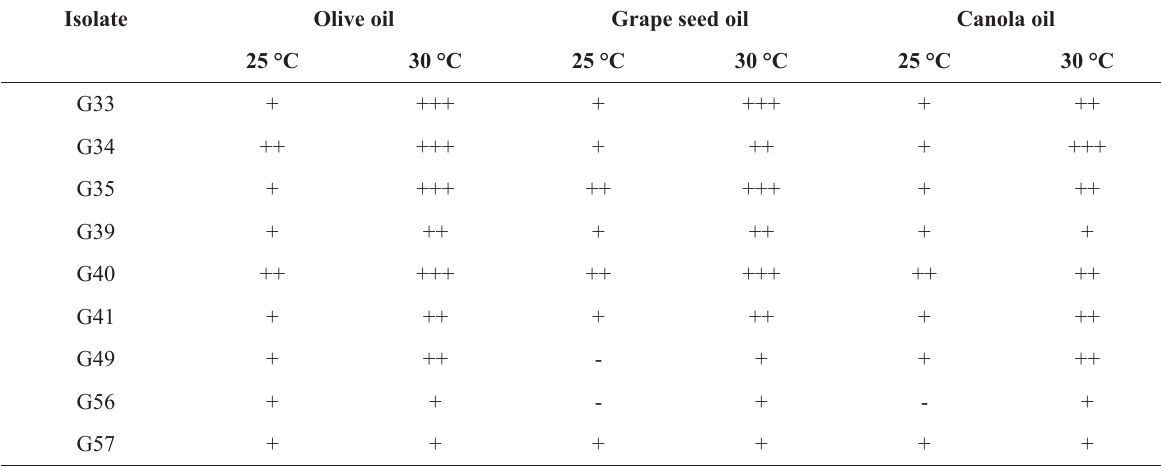
Results of fluorescence intensity obtained by the isolates in solid medium using olive oil, grape seeds oil and canola oil as substrates. Growth at 25 °C and 30 °C for 72